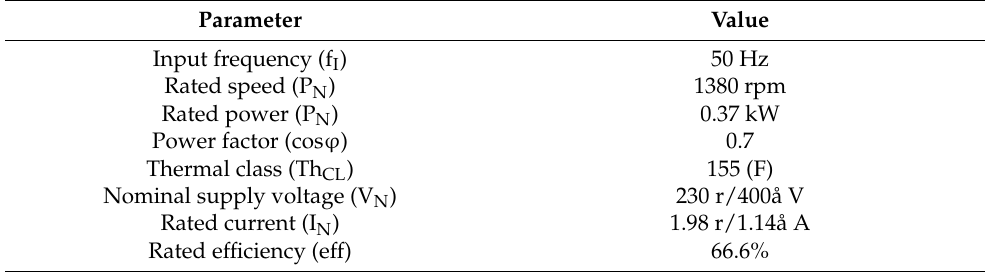
Table 2. Parameters of the tested electric motor (DRS71S4BE05/FI/TF/ES7S). Parameter